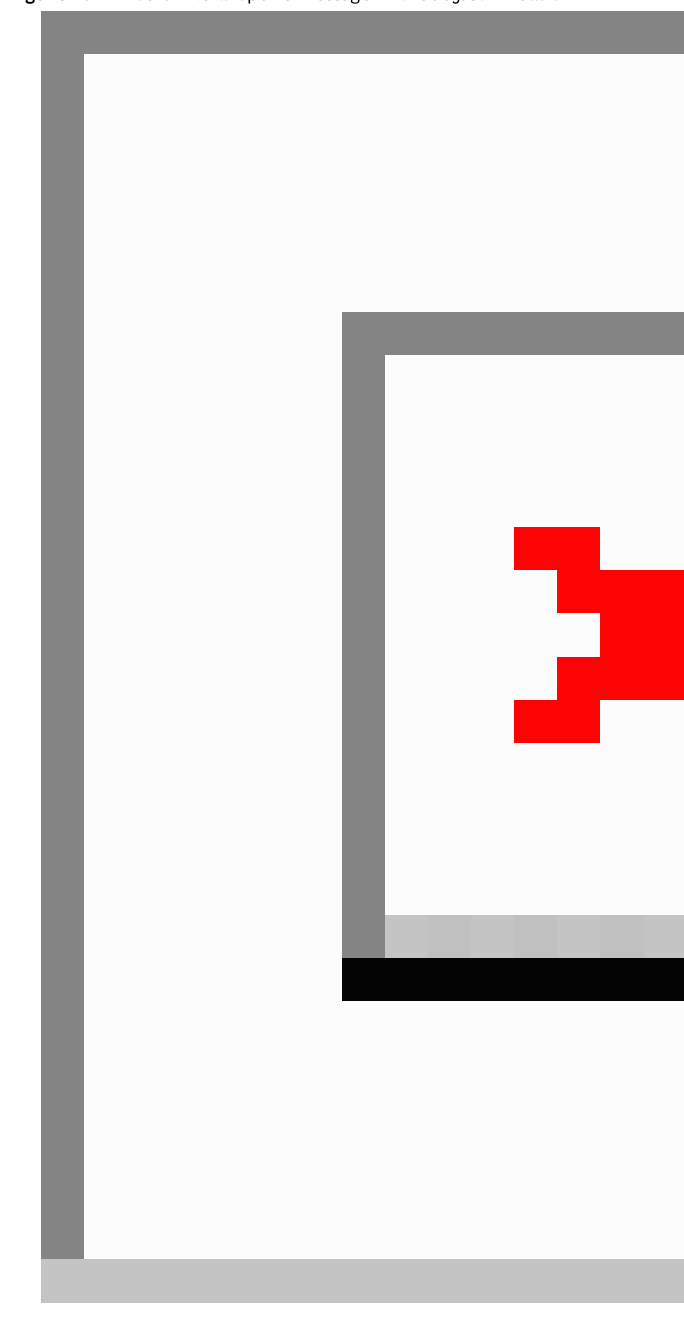
Figure 1. “I would like to open a message with Subject Line...”.